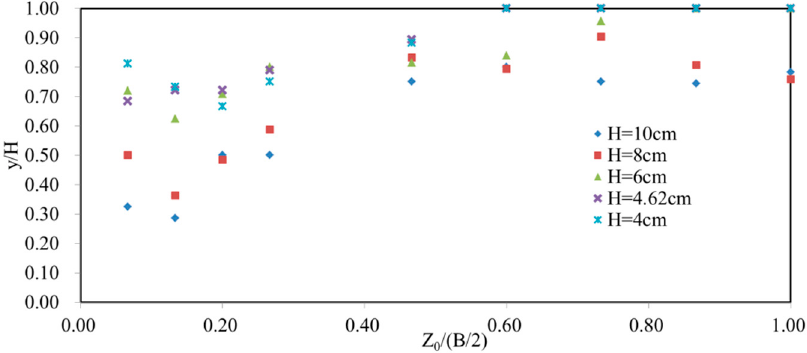
Figure 7. Relative position of the maximum velocity in the cross section.